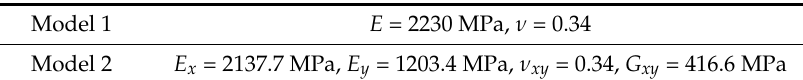
Table 1. Material properties,